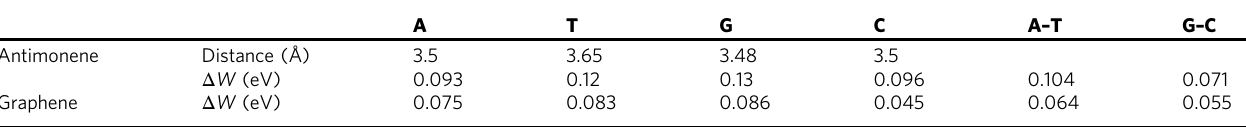
The calculated work functions of isolated antimonene and graphene are 4.389 and 4.208eV,